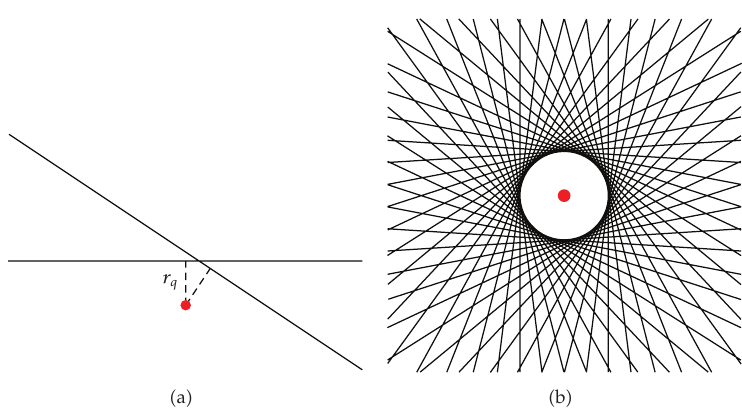
Figure 3: These pictures depict analogous situations to the case of flavored branes, when the fundamental fields are massive. (cid:5) b (cid:6) Again, we add a large number of lines, such that in the limit radial symmetry is